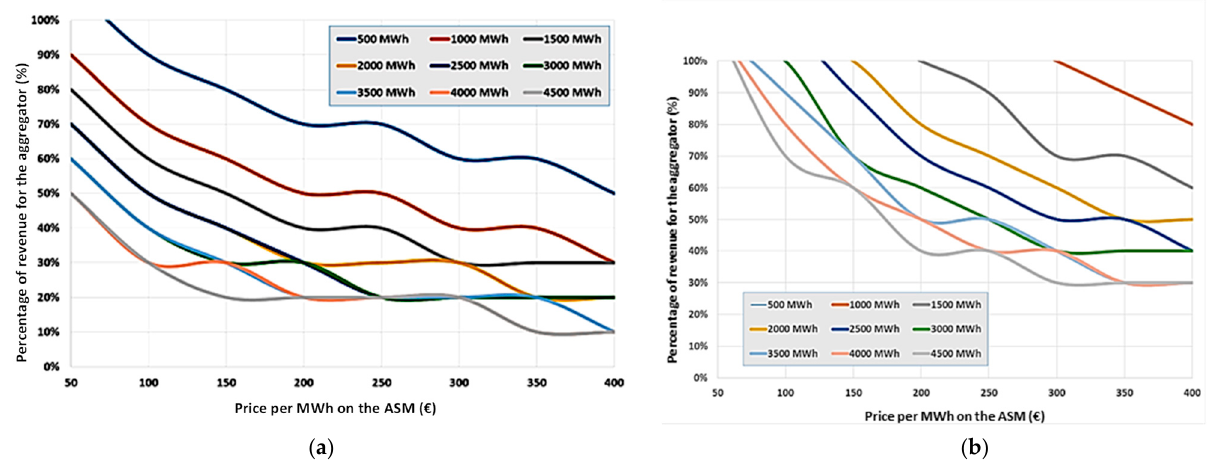
Figure 10. Profit of the areas of convenience areas as a function of the communication costs variation ( a ) EMP costs = 115 and COM costs = 0; ( b ) EMP costs = 115 and COM costs = 50.